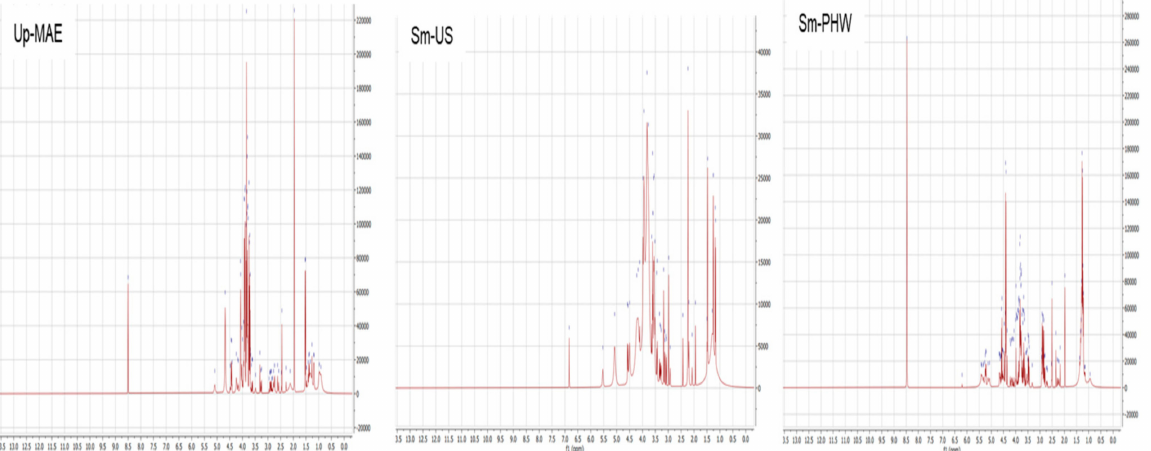
Figure 3. 1 H NMR spectra of crude fucoidan from Sargassum muticum (Sm) after ultrasound-assisted extraction (Sm-US) and pressurized hot-water extraction (Sm-PHW), and crude fucoidan from Undaria pinnatifida (Up-MAE) after microwave-assisted